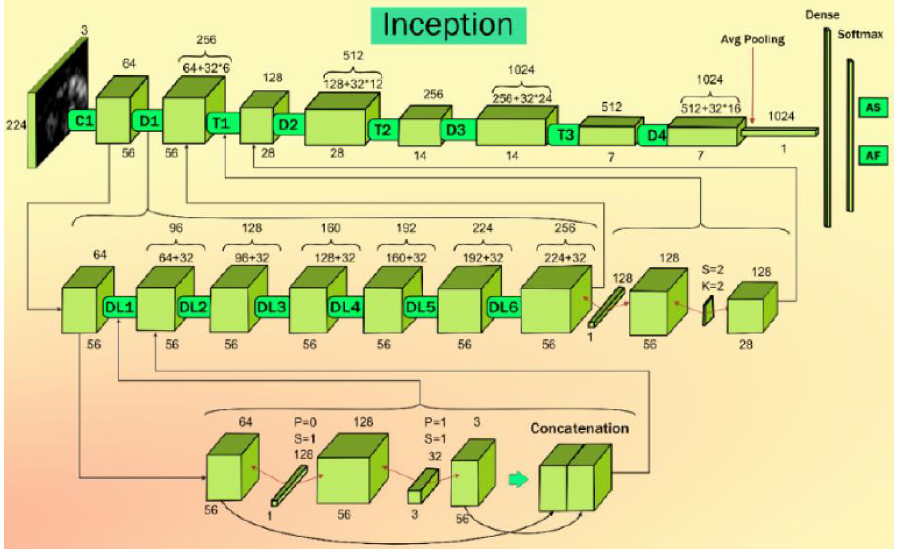
Figure A3. The general structure of InceptionV3 architecture